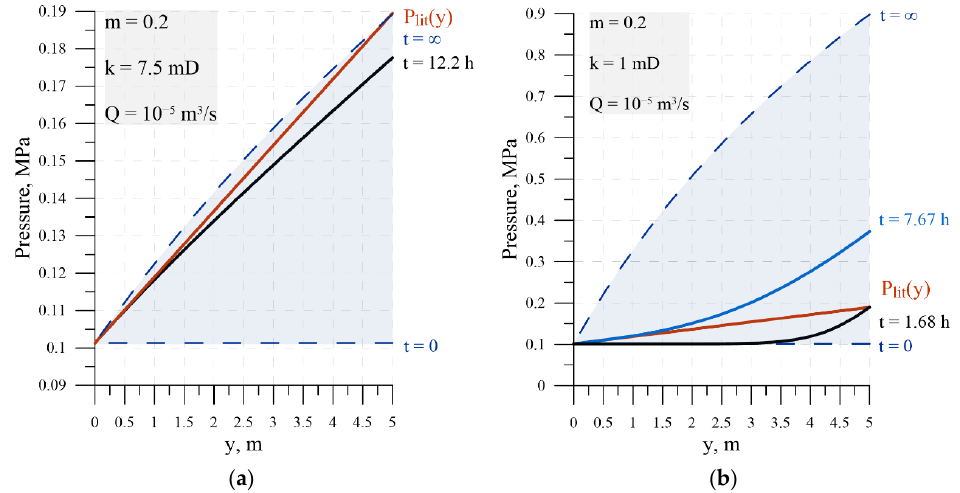
Figure 3. Pressure profile along the gas conduit at 1.68 h, 7.67 h ( a ), and 12.2 h ( b ) after t 0 . Blue dash line tracks depth-dependent pressure variations at t 0 and at the time of stabilization (in the absence of failure). Gas pressure in the channel may never reach the overburden pressure (Figure 4a), and no blowout will occur, or it may rise to the critical value all over the channel (Figure 4b).